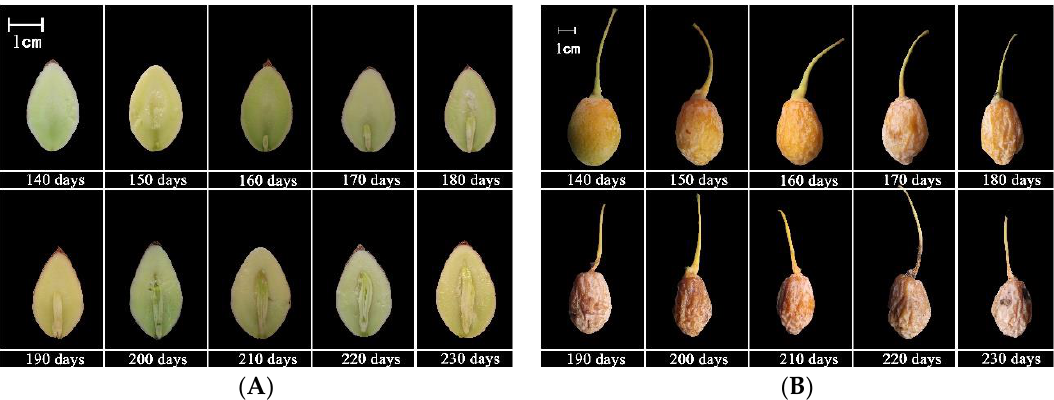
Figure 1. Morphological changes during embryo development in Ginkgo biloba L. ‘Jiafozhi’ Bar = 1 cm. ( A ) 140–230 days after flowering (DAF): embryo development of Ginkgo biloba L. ‘Jiafozhi’ seeds; ( B ) 140–230 DAF: the morphological changes of the sarcotesta.